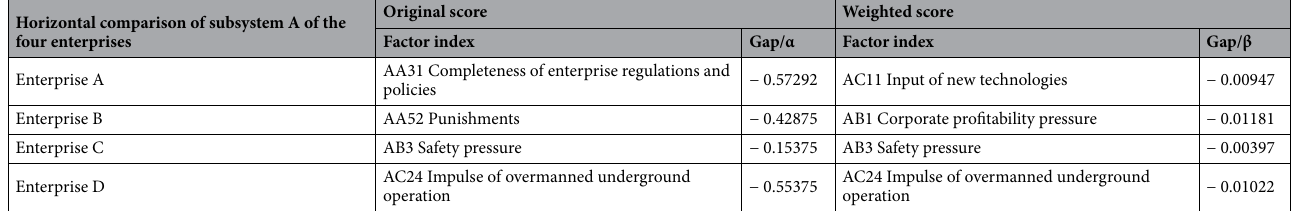
Table 15. Analysis of the shortcomings of the basic index scores of the safety management in four companies (subsystem A)—horizontal comparison.